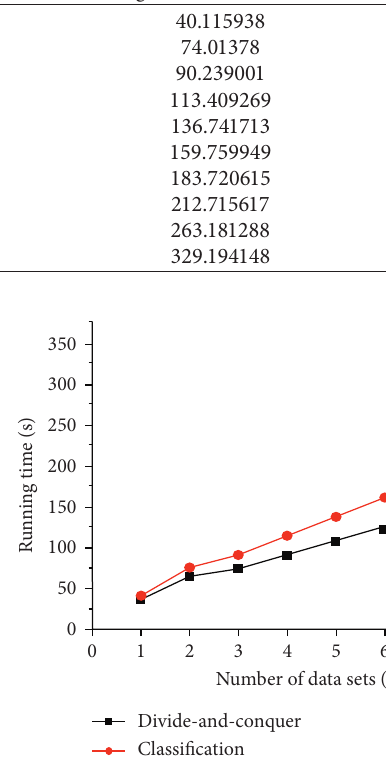
Table 1: Attribute reduction results of the two algorithms in nonparallel testing. Number of data sets